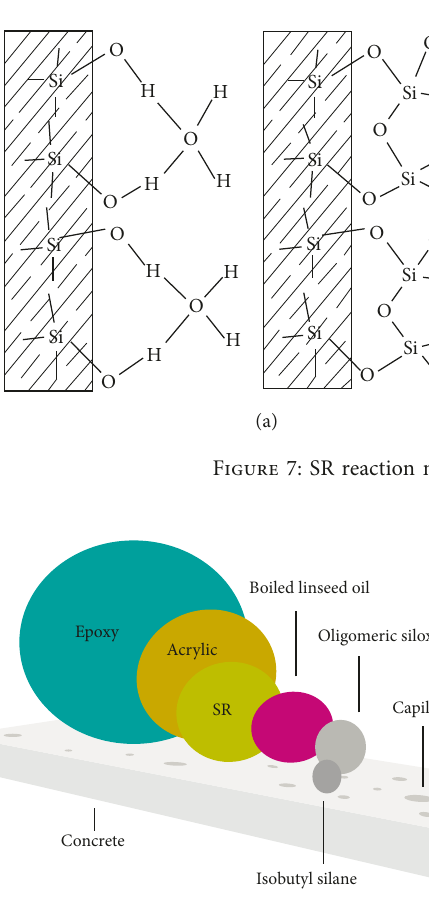
Figure 8: Diagrammatic representation of molecular size of dif- ferent hydrophobic agents in comparison with the capillary pores of concrete.